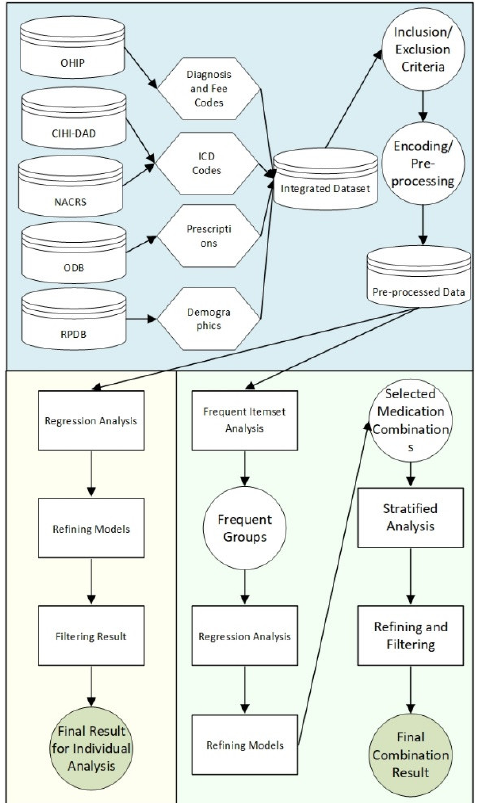
Figure 1. Workflow diagram of the study presented in this paper. Different colors are used to show the separation of three main parts (pre-processing, individual analysis and combination analysis).